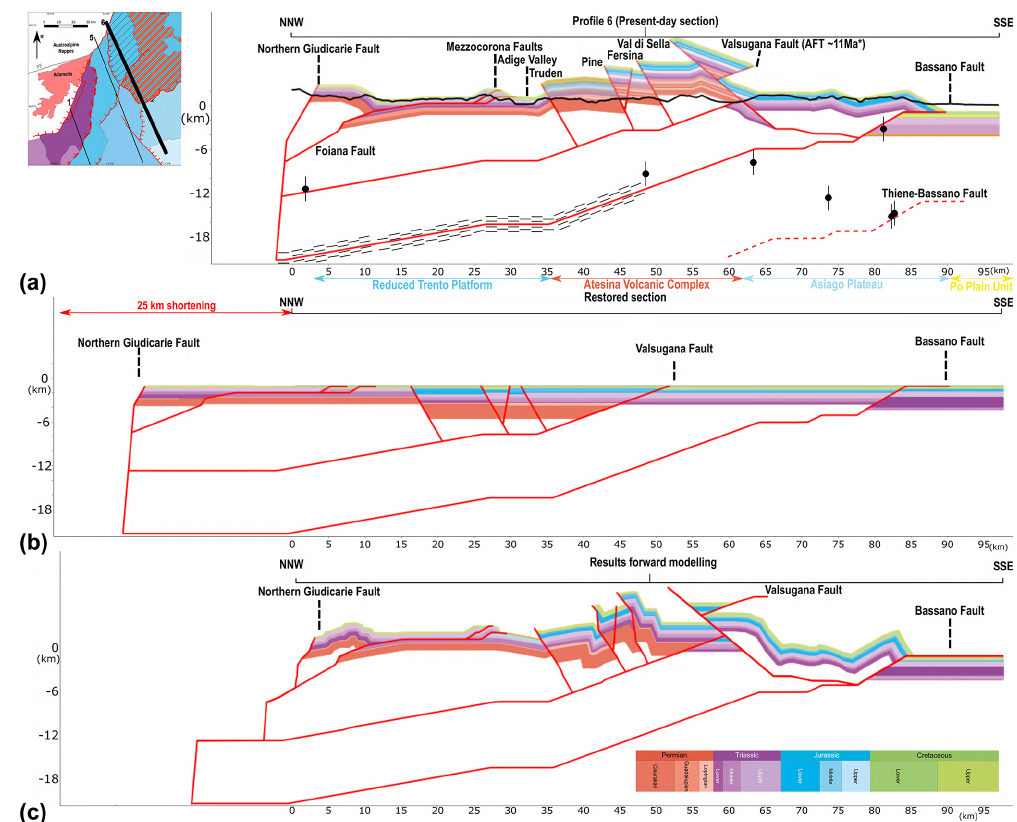
Figure 9. (a) Profile 6 across the Reduced Trento Platform, Atesina Volcanic Complex, and the Asiago Plateau (AFT age for Valsugana Fault from Heberer et al., 2016). (b) Profile 6 retro-deformed to a layer-cake stratigraphy. (c) Results of forward modelling. Colours in the legend are modified following the International Chronostratigraphic Chart, with the pre-Permian basement beneath in white. Black dots indicate hypocentres of seismic events during 2017–2018 (SWATH-D Network; Jozi Najafabadi et al., 2021; vertical bars indicate the average error range on hypocentre depths), projected from a swath extending to 6km on either side of the profile. Dashed black lines below ∼ 10km indicate ductile